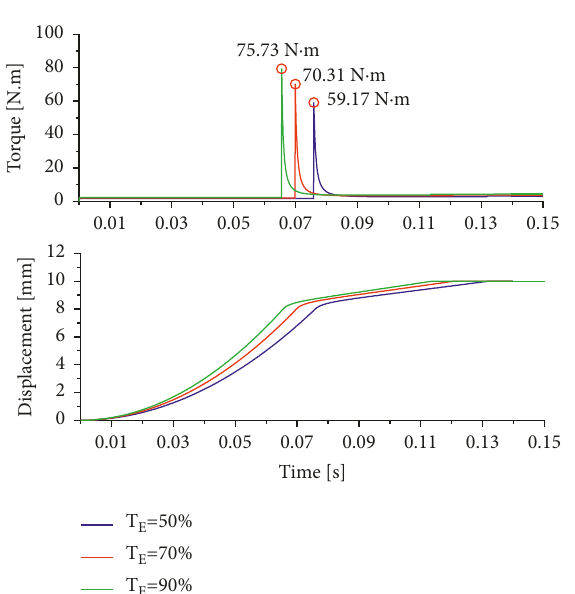
Figure 7: Torque on the spiral spline and displacement of the sliding unit.